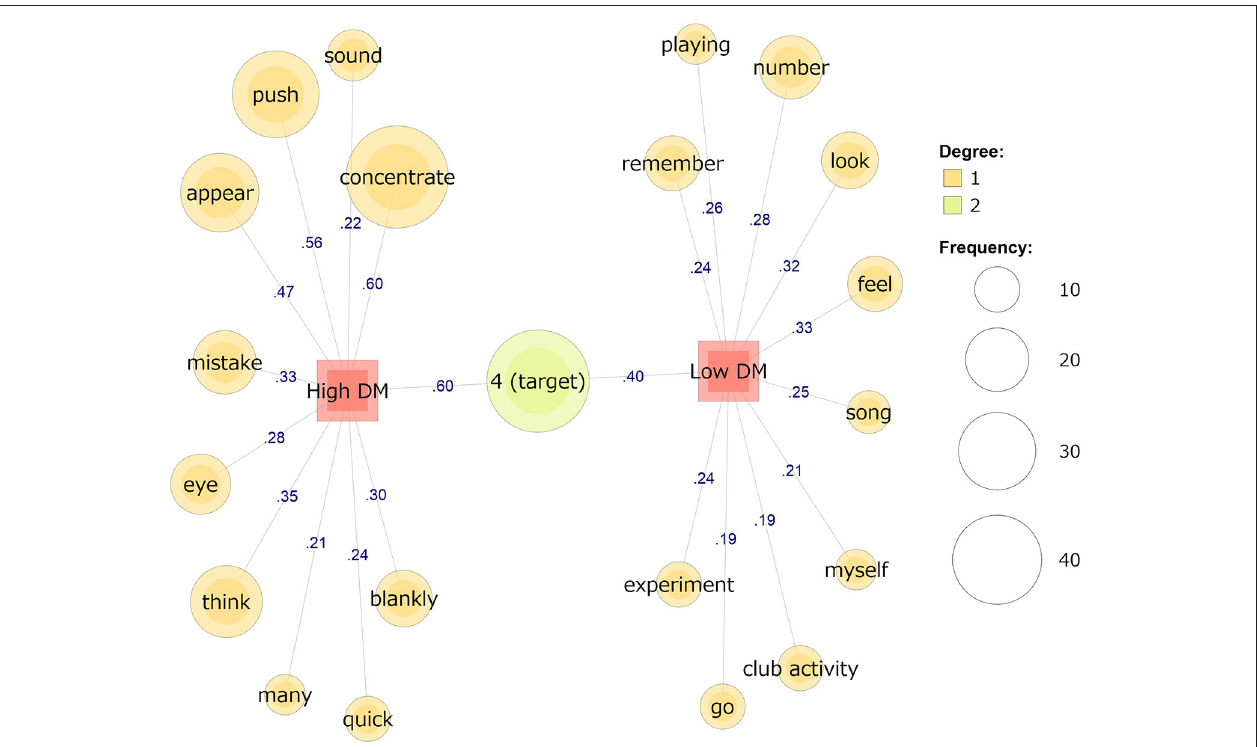
FIGURE 1 | Comparison of the co-occurrence networks for self-reported mind wandering between the high ( n = 32) and low ( n = 21) groups for decision-making skills. The values on the line are Jaccard coefficients.